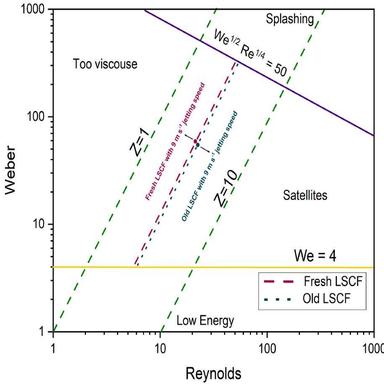
Derby diagram for fresh and old LSCF ink. The dashed and dotted lines are the printability indicators of fresh and old LSCF inks for a drop velocity of 3–20 m s − 1 . The dots represent the inks spots in the derby diagram with 9 m s − 1 drop velocity, provided by the used waveform. The diagram has been presented by Derby .